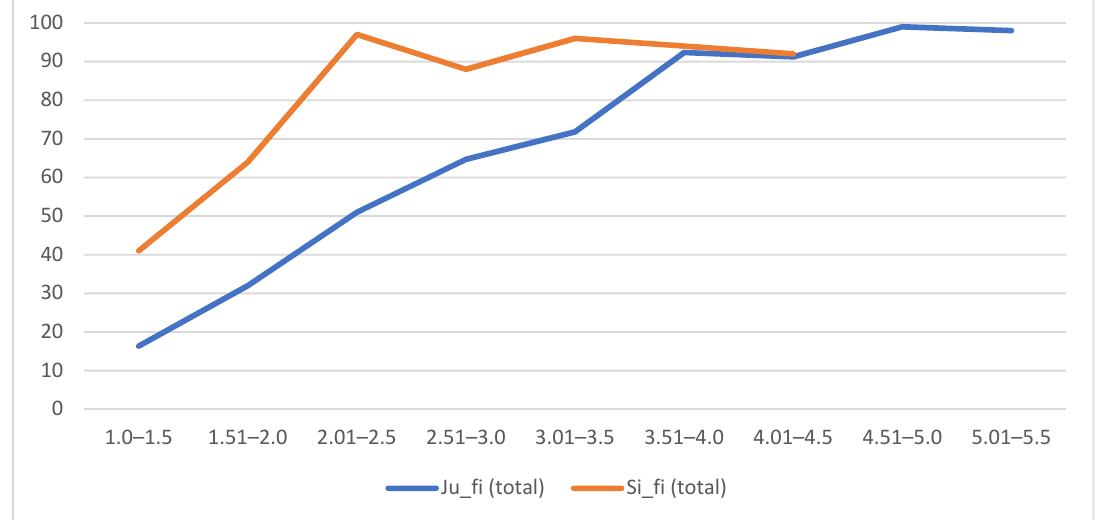
Figure 6. Total D realizations compared (%).